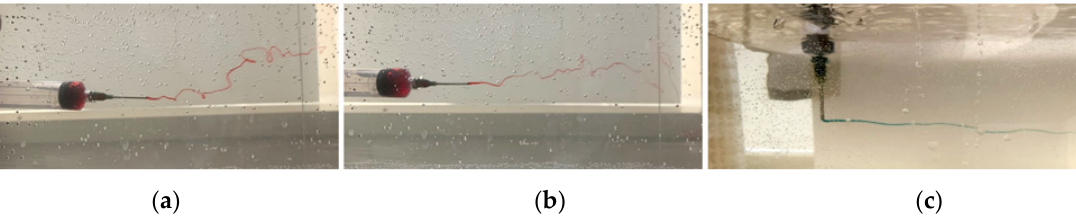
Figure 15. The flow behavior at about 10 cm/sec. was observed using color dye injected by a syringe. The left panel ( a ) shows the dispersion of the dye when no flow straightener was used. Turbulence characteristic can be seen from the dyes. Panels ( b , c ) shows the flow characteristic when Model 2 is used as flow straightener. Straight streamline is easily observed in this case.